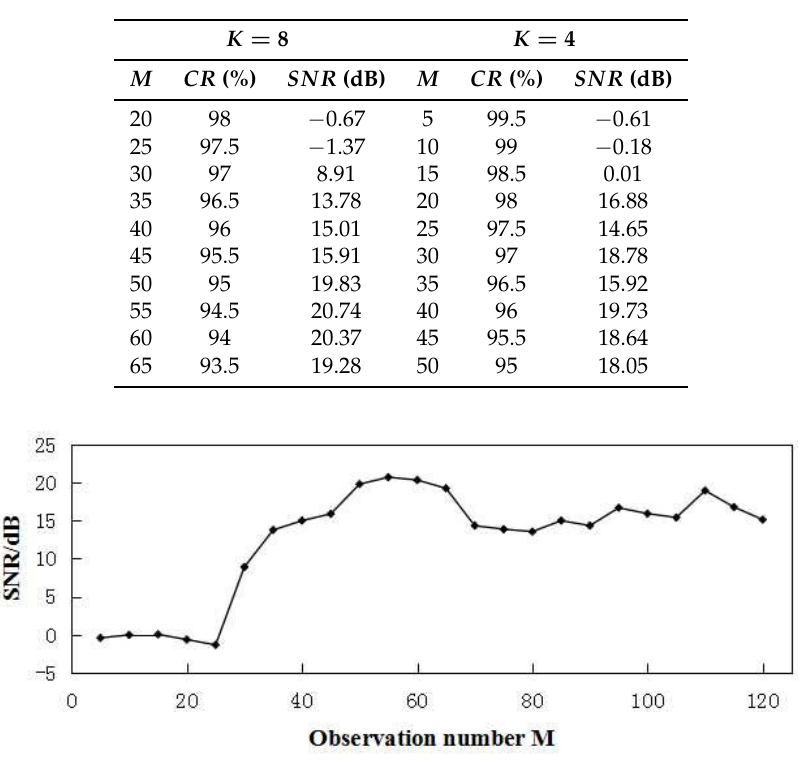
Table 1. Simulation results under different CR with K = 8 and K = 4.